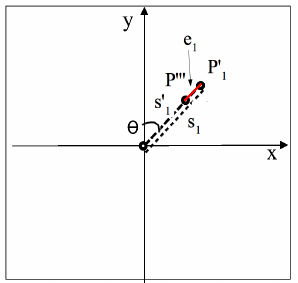
Figure 7. Radial distance s 1 , relief displacement e , angle θ and corrected radial distance s'